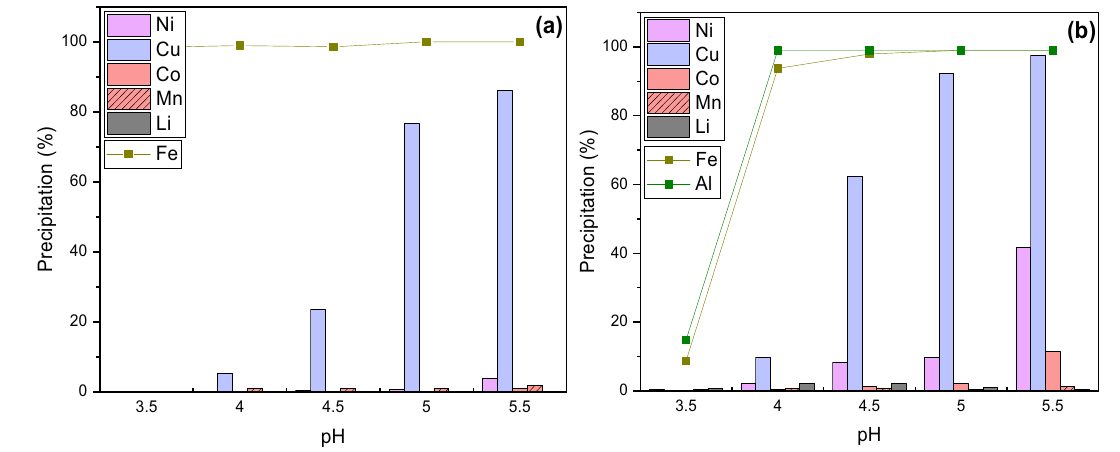
Figure 2. Precipitation using NaOH at 60 °C with ( a ) 0 and ( b ) 2 g/L of Al in the